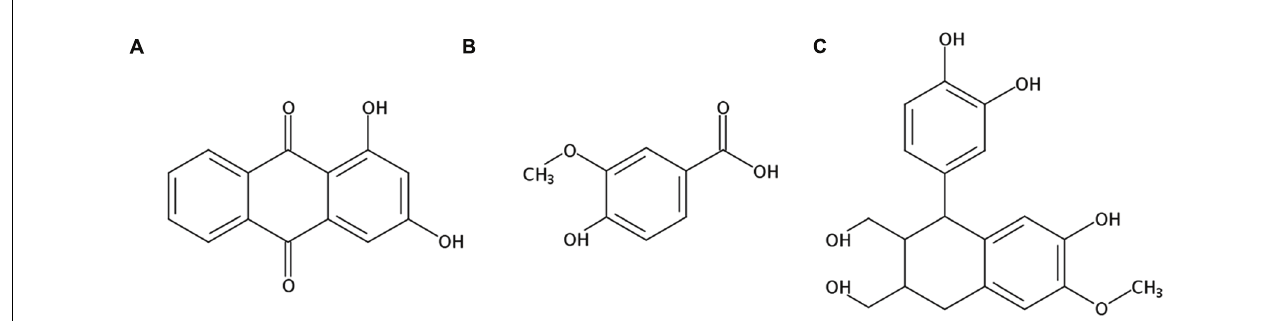
FIGURE 6 | Structures of components isolated and identified from the ethyl acetate fraction of RCAP aqueous extraction. (A) 1,3-dihydroxy-9, 10-anthracenedione (xanthopurpurin); (B) 4-hydroxy-3-methoxybenzoic acid (vanillic acid); (C) 1-(3,4-dihydroxyphenyl)-1,2,3,4-tetrahydro-7-hydroxy-6-methoxy-2, 3-naphthalenedimethanol